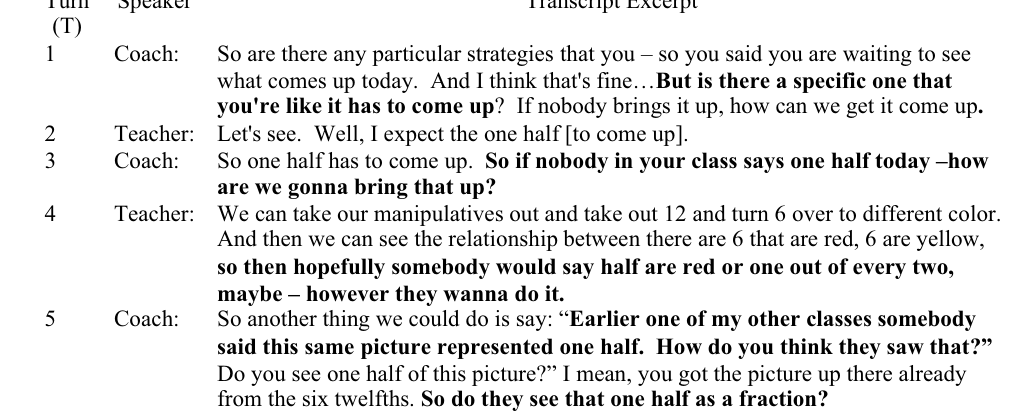
Fig. 4 Excerpt illustrating high-growth theme